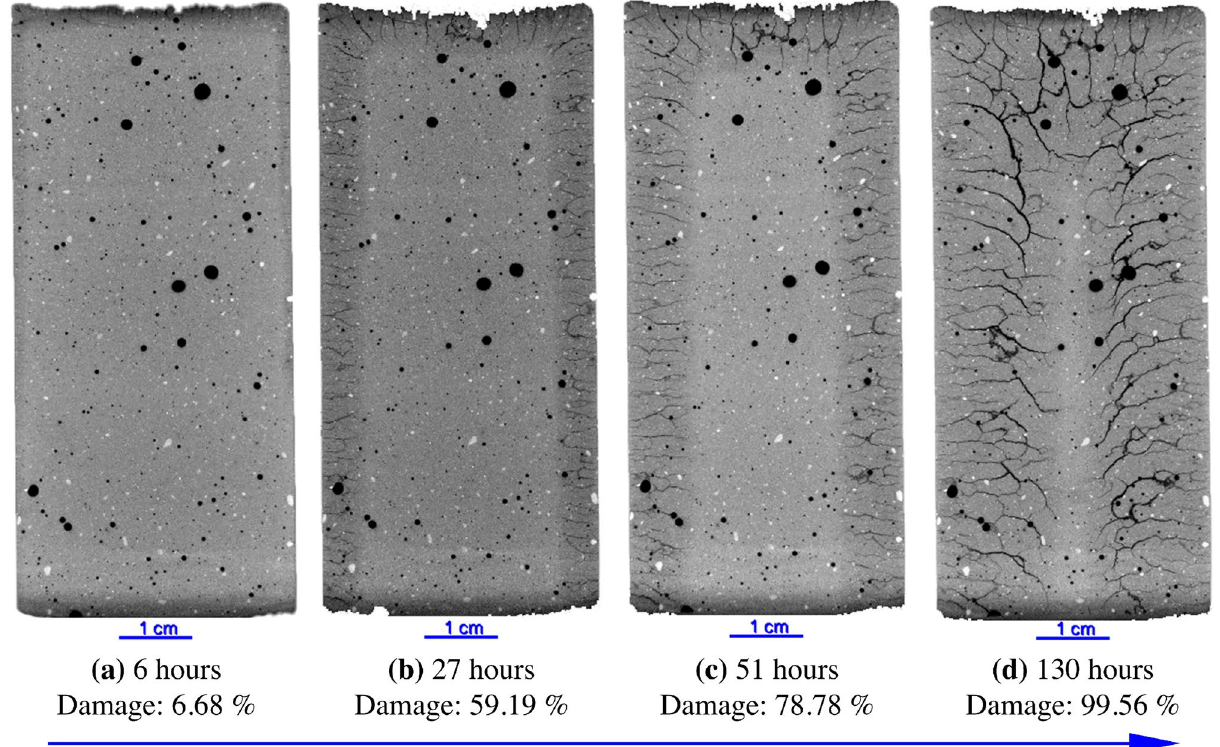
Figure 3. 2D images from the center of the interior of the CB-SK10 geo-architected sample with 20% montmorillonite showing time dependent deformation during moisture loss, ( a – d ) presents drying front progression, reduction of the coherent undamaged material and growth of the crack network. Data are visualized with Dragonfly Pro software, Version 2020.2 for [Windows] from ORS 13